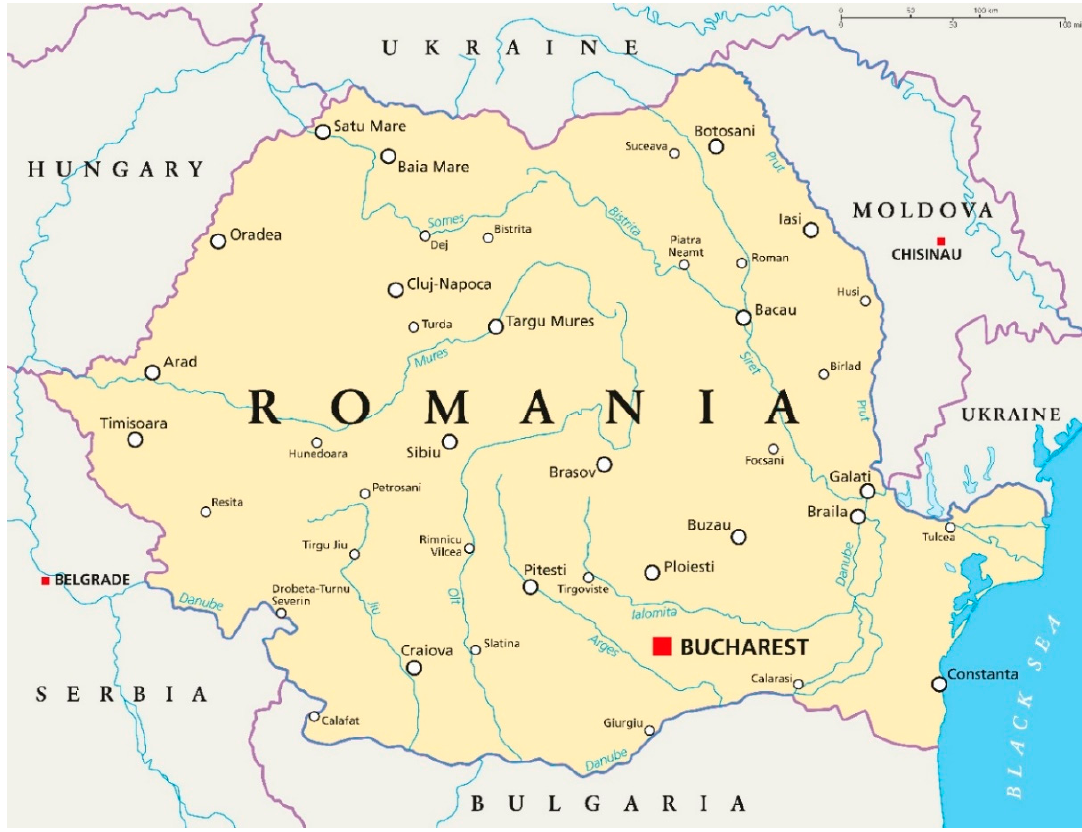
Figure 2. Map of Romania and its main population centres. Source: https: // www.shutterstock.com / nl /